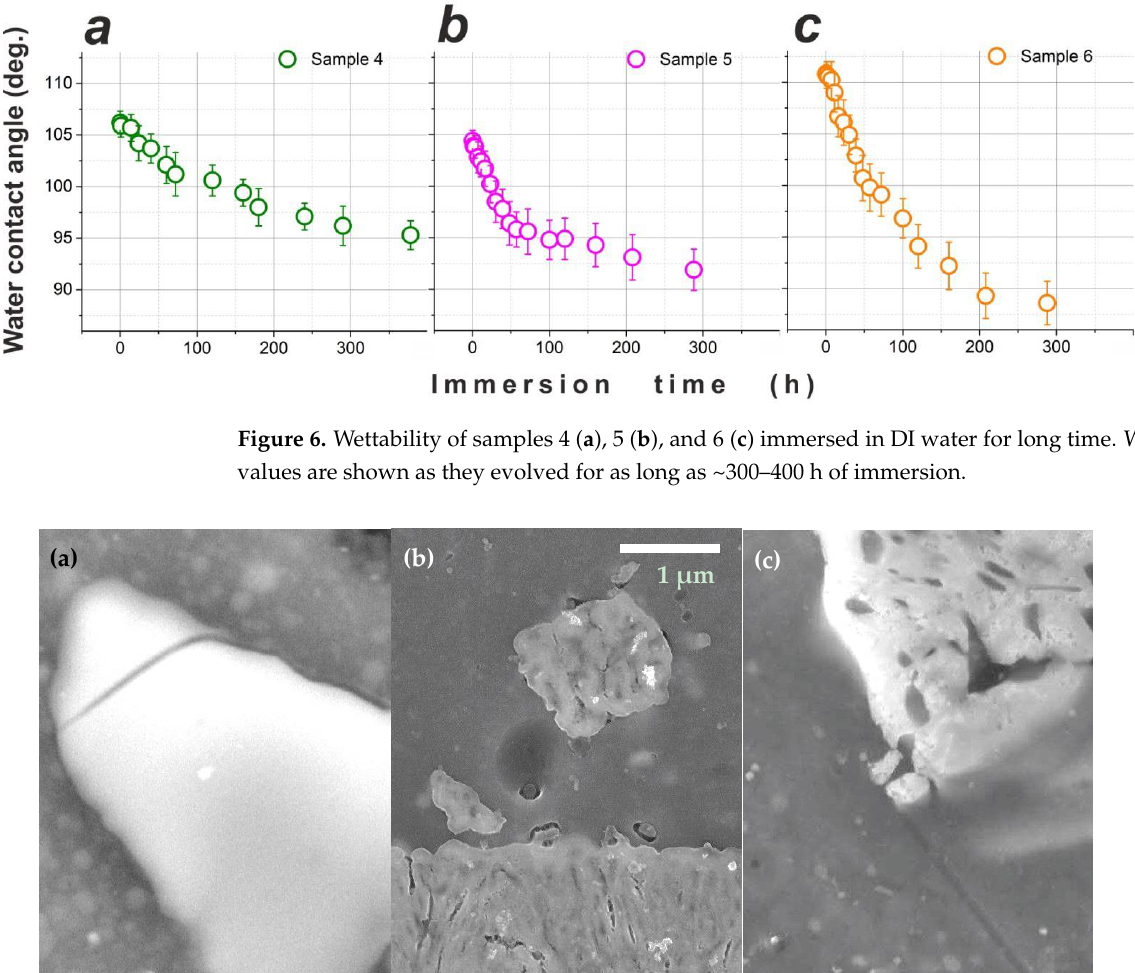
Figure 5. Surface SEM images of sample 2 after immersion into DI water for 24 h ( a , b ) and after sonication in DI for 60 min ( c ). Trenches surrounding surface intermetallic particles are seen, being a sign of electrochemical corrosion [8,41 – 43,49,50].